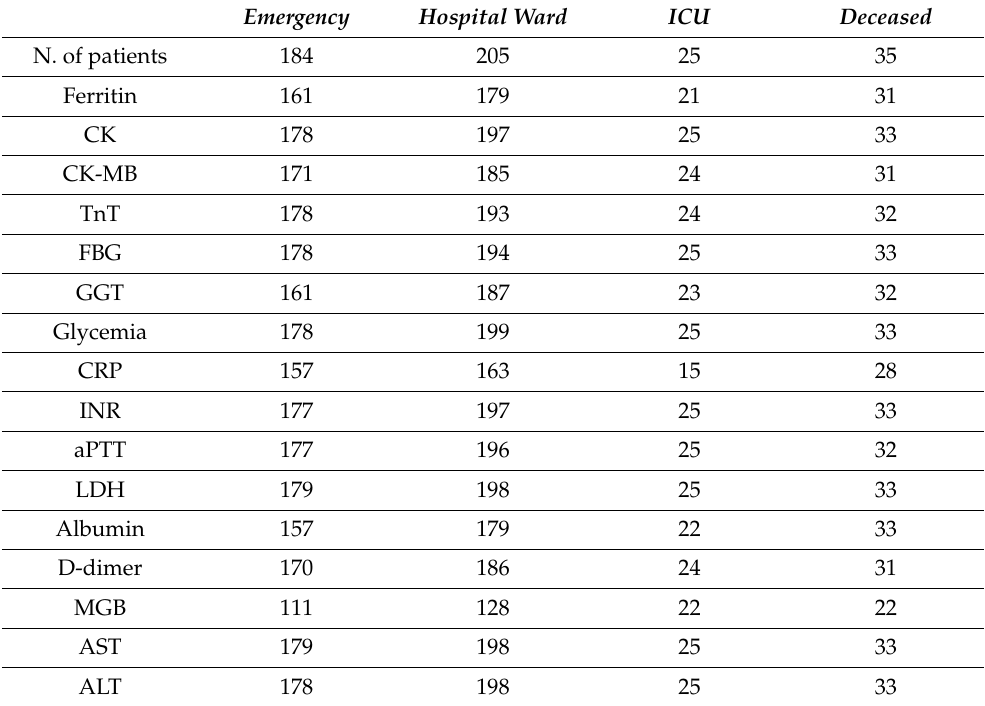
Table 2. Number of routine analyses available for each group and considered for the statistical